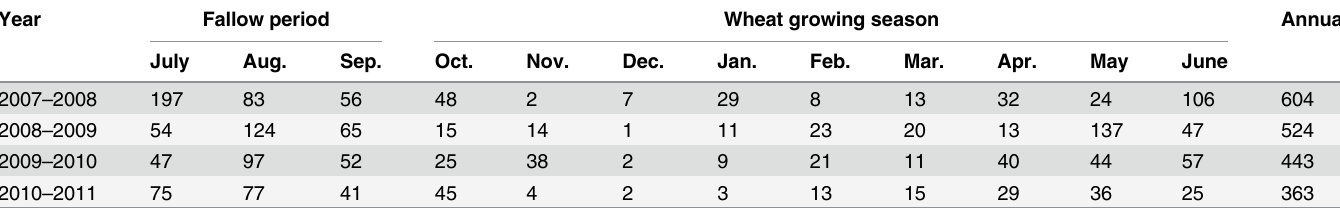
Table 2. Distribution of mean monthly precipitation (mm) at the experimental site during 2007 –